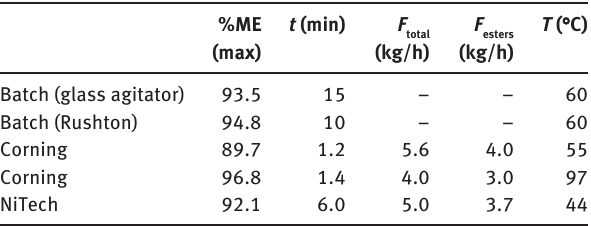
Table 2 Comparison of methyl ester mass fractions obtained in the three reactors for the transesterification reaction.